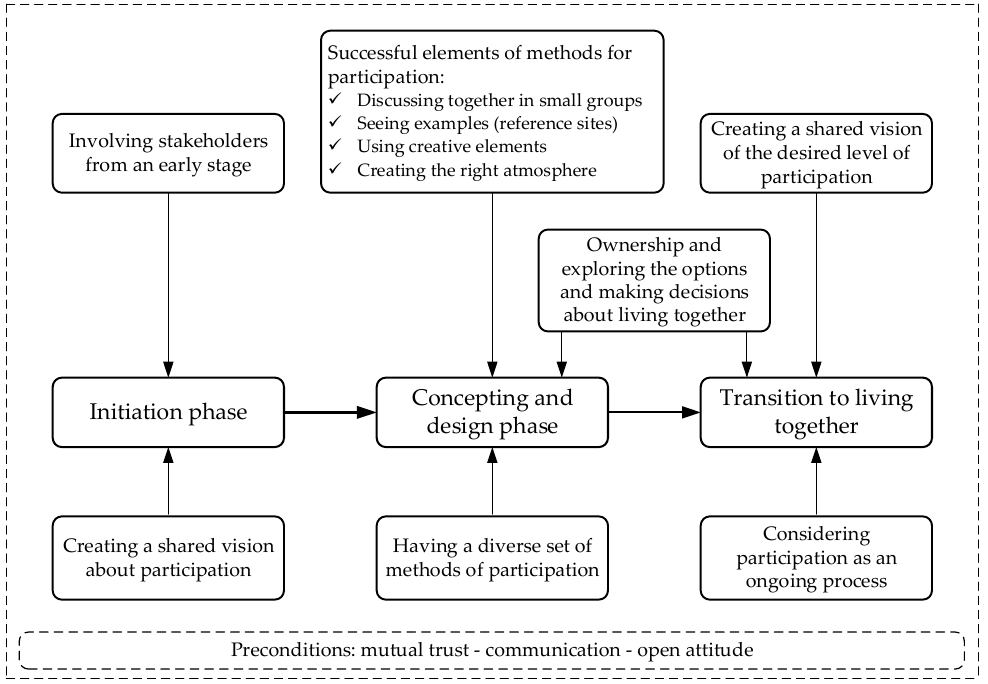
Figure 2. Lessons learned from experienced methods to facilitate meaningful participation.